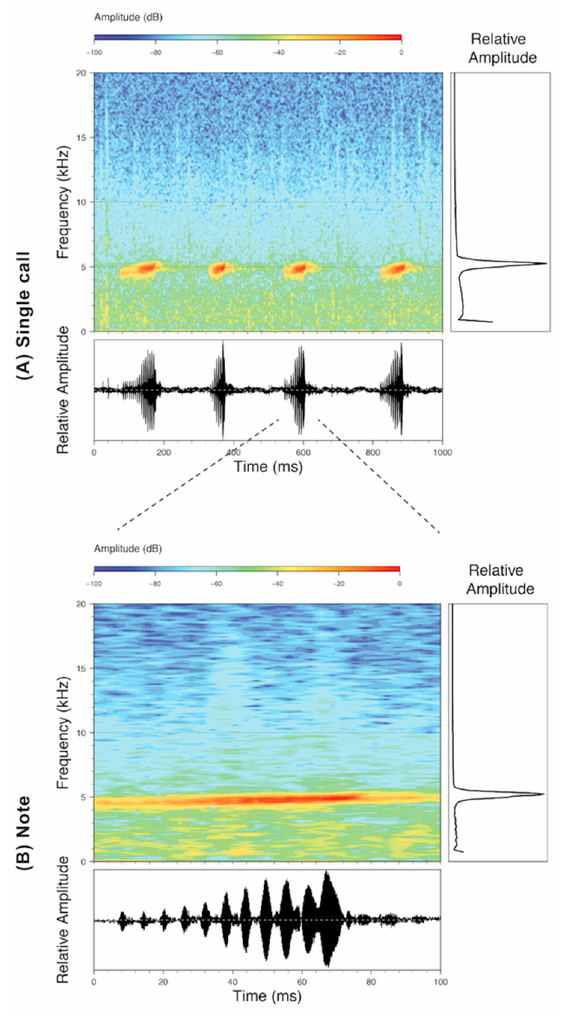
Figure 225. Calls of Vitreorana ritae , LBE-C-039, recorded by Morley Read at Boanamo Community, 240 m, Orellana province, Ecuador. ( A ) A single call with four notes. ( B ) A single note. Distribution (Figure 226): Vitreorana ritae is found from the Guianas across western Amazonia [17,222,229,300,313–316,318]. In Ecuador, the species has been reported from five localities in the provinces of Orellana and Sucumbíos at elevations below 260 m (Specimens Examined). In Ecuador, the potential distribution of the species is 42,600 km 2 within the Amazonian Tropical Rainforest region.